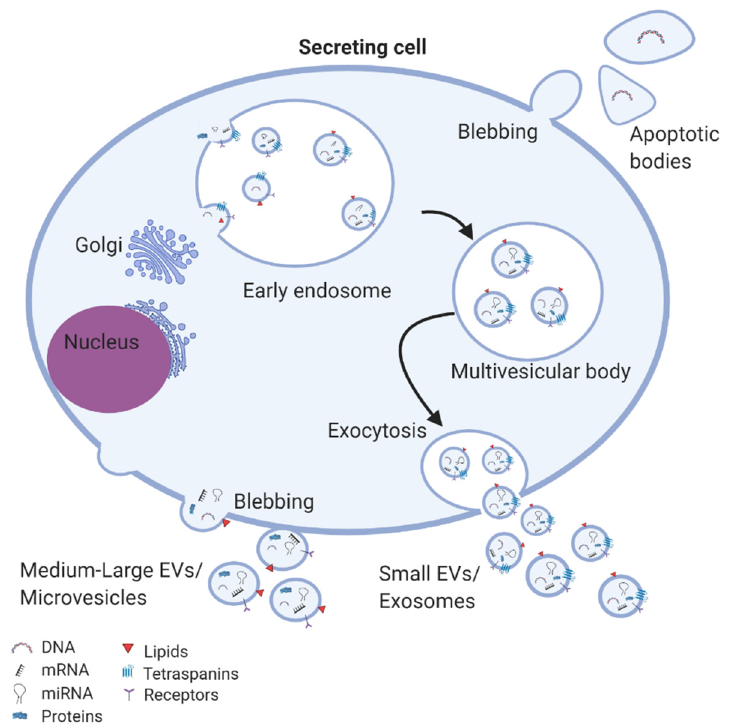
Figure 2. EV biogenesis and secretion: exosomes are assembled in multivesicular bodies where specific cargos are sorted into exosomes and subsequently released in the extracellular space. Microvesicles are formed from budding of the cell membrane. Apoptotic bodies are generated from apoptotic cells.